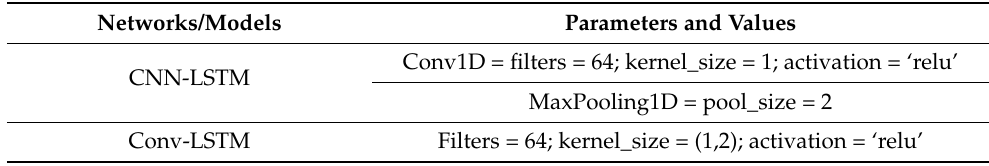
Table 4. Parameters and their assigned values of CNN-LSTM and